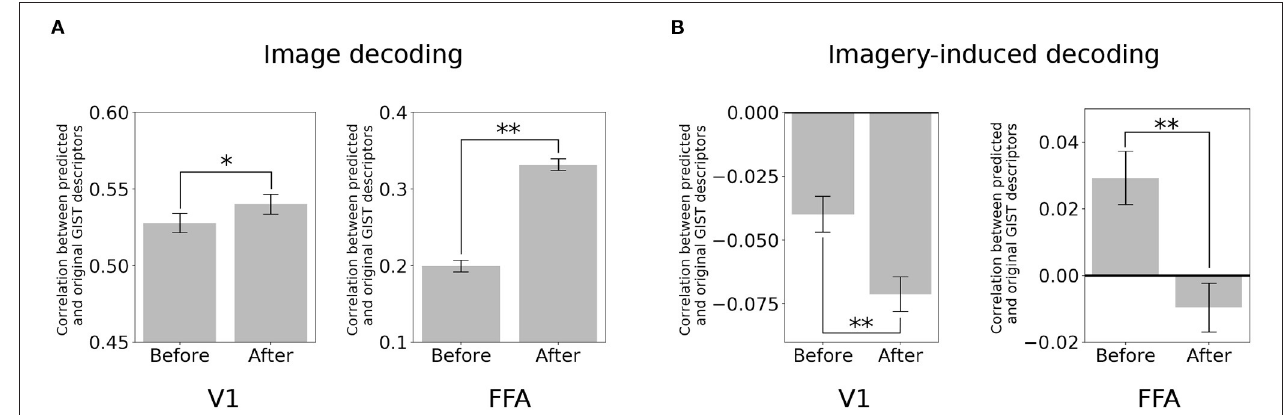
FIGURE 3 | Distillation analysis between V1 and FFA. (A) An example of V1 and FFA after distillation in predicting the GIST descriptors. Correlation between predicted and original GIST descriptors in the image-based perception task. (B) Correlation between predicted and original GIST descriptors in the class-based imagery task. Error bars represent standard error of measurement (SEM). * uncorrected p < 0.05, ** uncorrected p < 0.001; two-sided paired t -test after Fisher’s z-transform; n = 500.